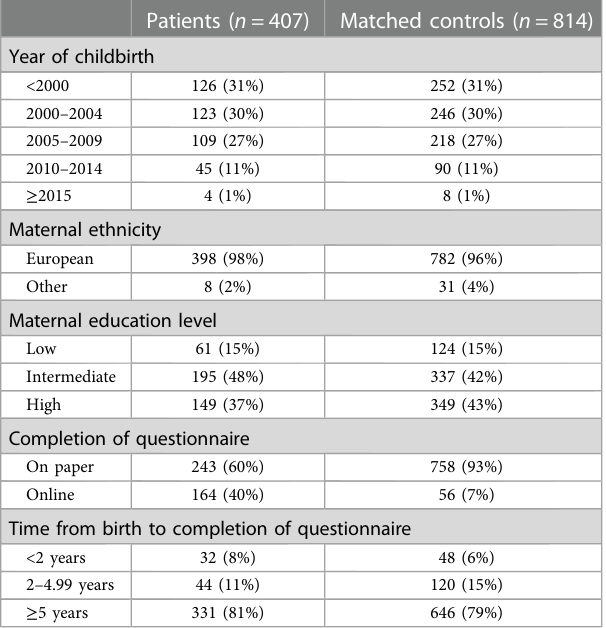
TABLE 1 Characteristics of patients with posterior urethral valves and healthy population-based controls matched on year of childbirth. Patients ( n =